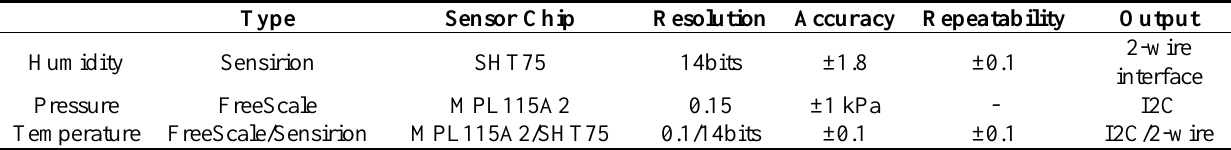
Table 2. Properties of sensors from manufacturer datasheet connected to the Raspberry-Pi